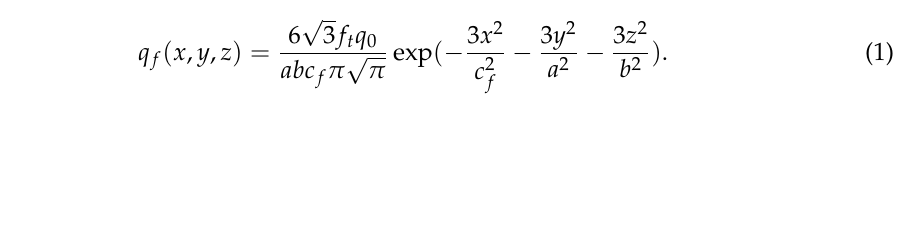
Figure 3. The weld diagram of duckbill welding parts.